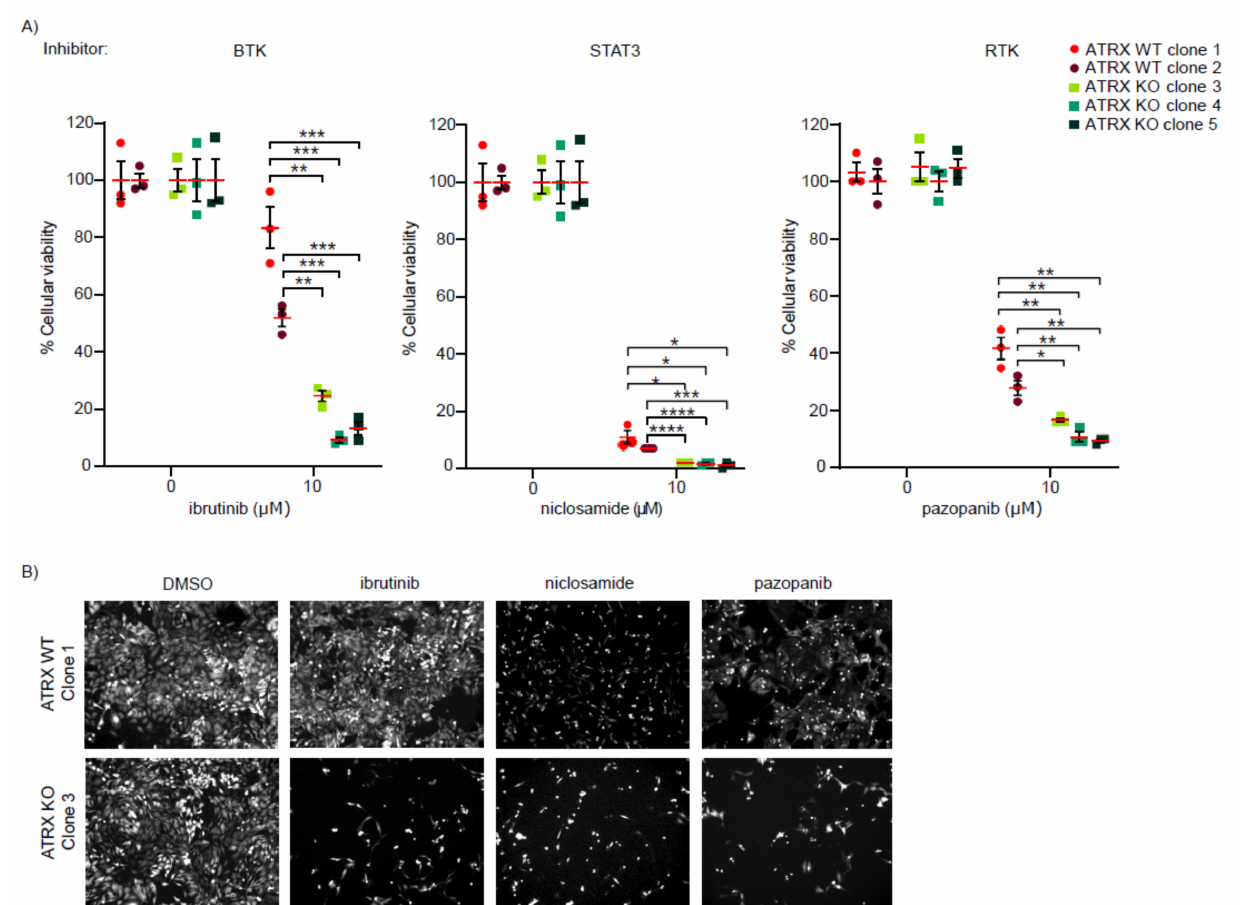
Figure 2. ATRX-deficient HeLa cells are susceptible to BTK, STAT3 and RTK inhibitors. ( A ) Cell viability of tdTomato-ATRX WT and GFP-ATRX KO HeLa clones after 72 h of treatment with the indicated drugs and concentrations compared to DMSO controls. Data shown correspond to technical triplicates. Means and SEMs are shown. Statistics for significant conditions are shown. Significance was assessed by unpaired t -test. * p ≤ 0.05; ** p ≤ 0.01; *** p ≤ 0.001; **** p ≤ 0.0001. ( B ) Representative images of clone 1 (ATRX WT) and clone 3 (ATRX KO) after 72 h of treatment with either DMSO or the indicated drugs at a concentration of 10 µ